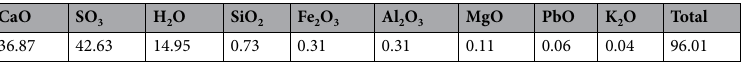
Table 1. The chemical composition of the FGD gypsum